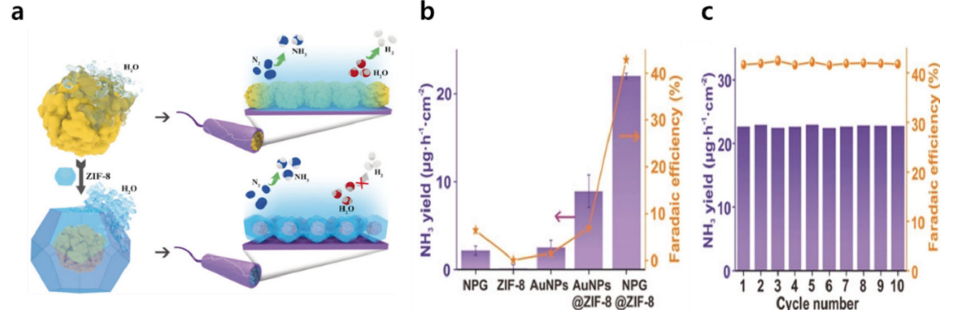
Figure 5. ( a ) Enhancement of N 2 reduction by the NPG@ZIF-8 electrocatalyst. ( b ) Comparison of the FEs and NH 3 production rates (NH 3 yield rates) for the presence and absence of ZIF-8 encapsulation at − 0.6 V RHE . ( c ) Stability tests of the NPG@ZIF-8 catalyst at − 0.6 V RHE . Reproduced with permission [19]. Copyright 2019,